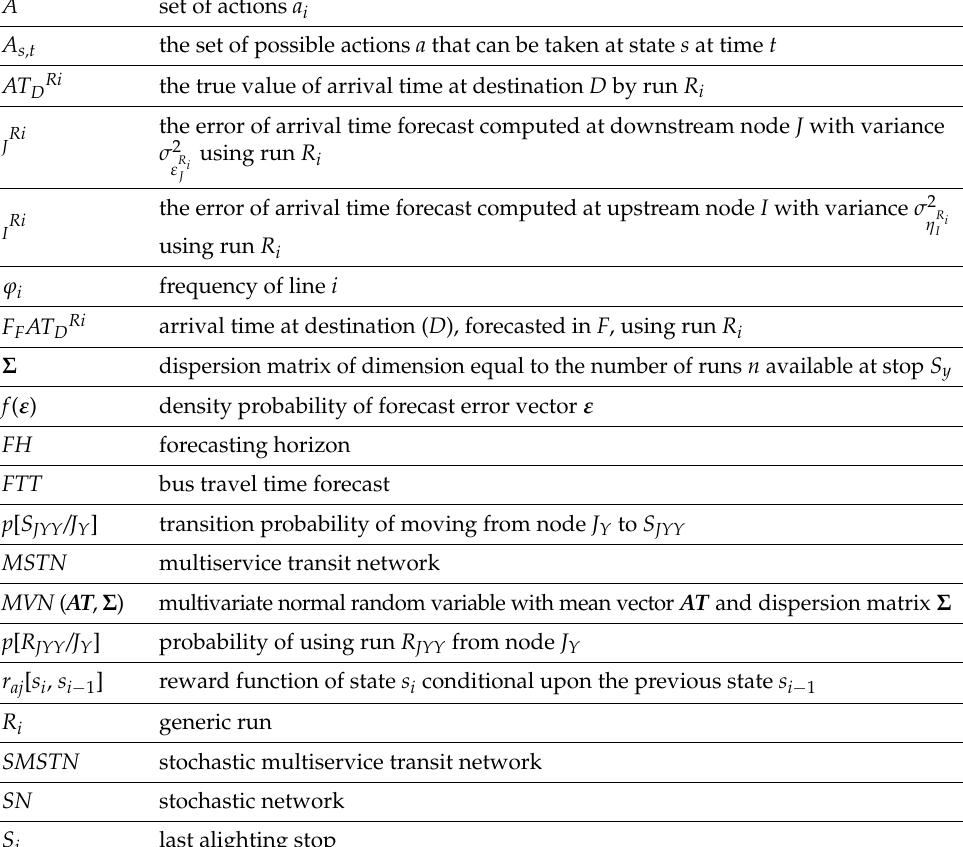
Table 1. Notation